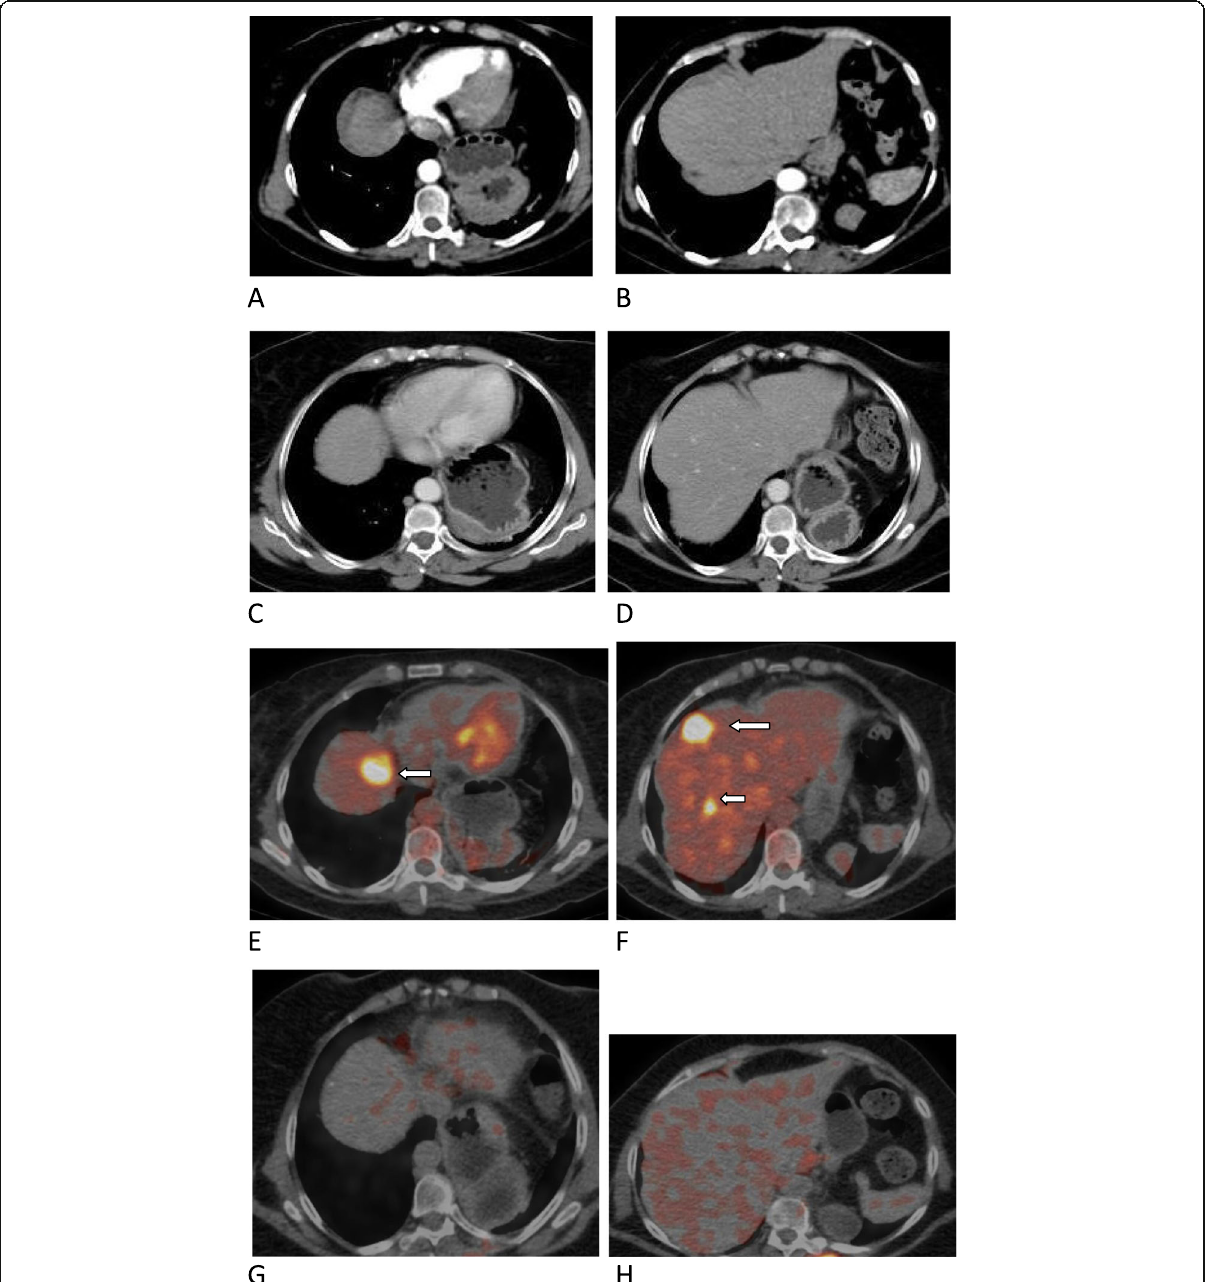
Fig. 3 A 64-year-old female patient who underwent surgical resection for pathologically proven colonic adenocarcinoma, presented with an elevated tumor marker. a , b Axial post-contrast CT images in arterial phase showing no enhancing focal lesion. c , d Axial post-contrast CT images in porto venous phase showing no enhancing focal lesion. e , f , d Axial fused PET – CT images at the same level of the enhanced CT images showing metabolically active hepatic focal lesions (arrows). g , h Post-therapeutic axial fused PET – CT images showed good therapeutic